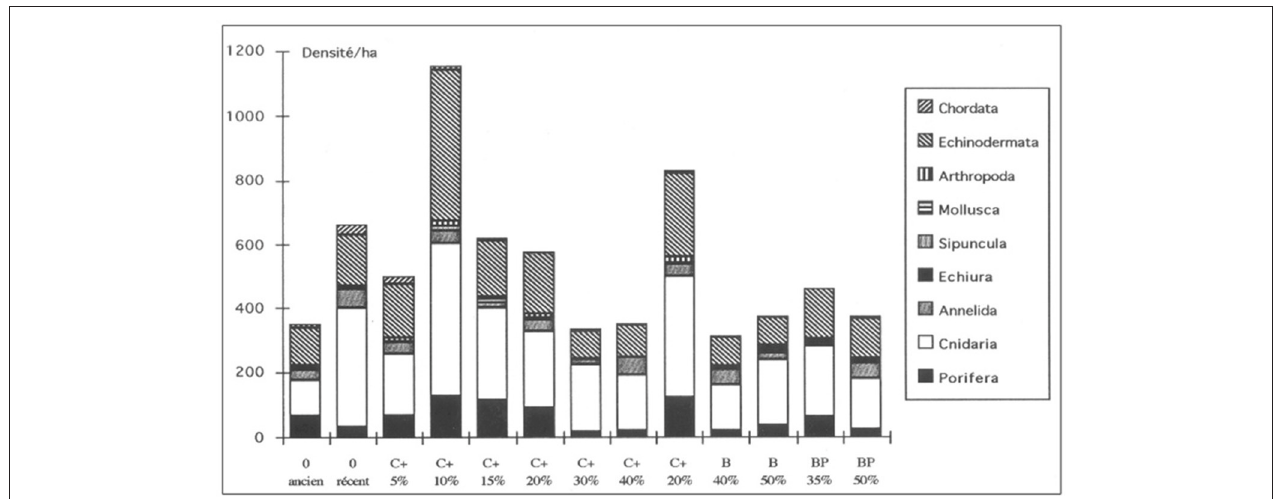
FIGURE 5 | Histogram of the partitioned faunal abundance for each nodule-facies on NIXO 45 (http://unesdoc.unesco.org/images/0014/001495/149556f.pdf, volume 1 Figure